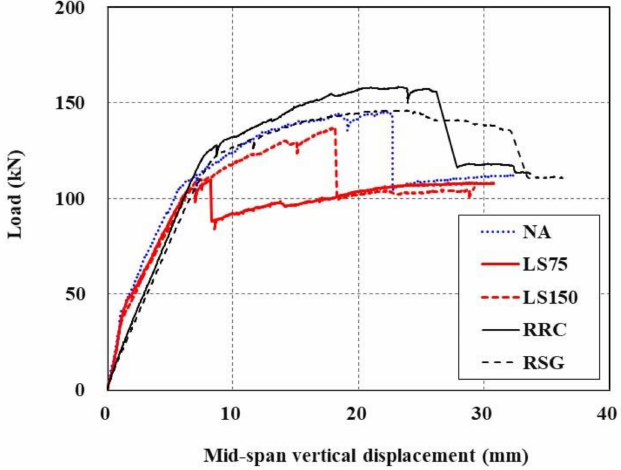
Figure 13. Load-displacement curves of RC slabs strengthened with TRC